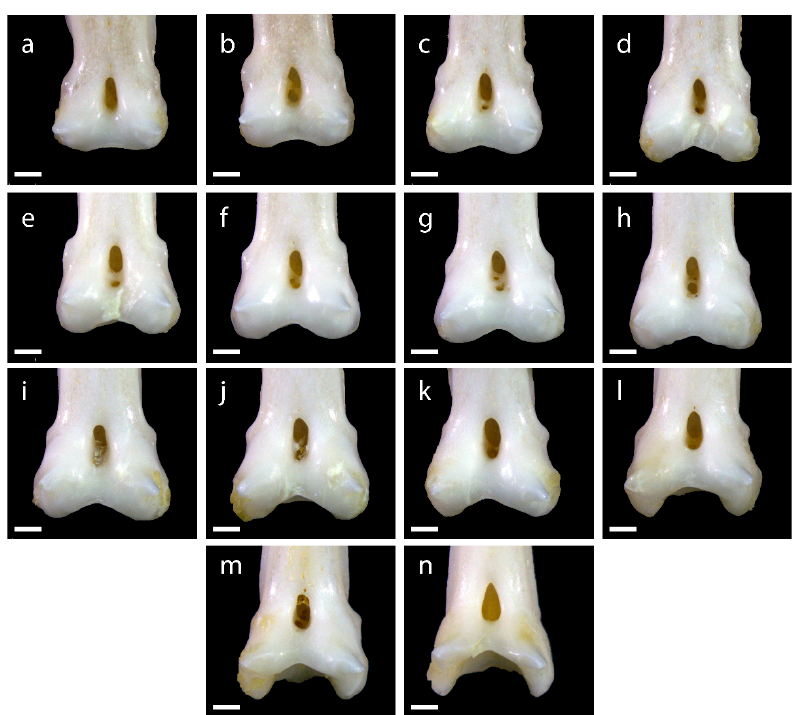
Figure A3. Microscopic images of the posterior view of the pinnules of P. bichir PO3. The images ( a – n ) correspond to the 1st, 2nd, 3rd, 4th, 5th, 6th, 7th, 8th, 9th, 10th, 11th, 12th, 13th, and 14th pinnules, respectively. Scale bars = 1 mm.